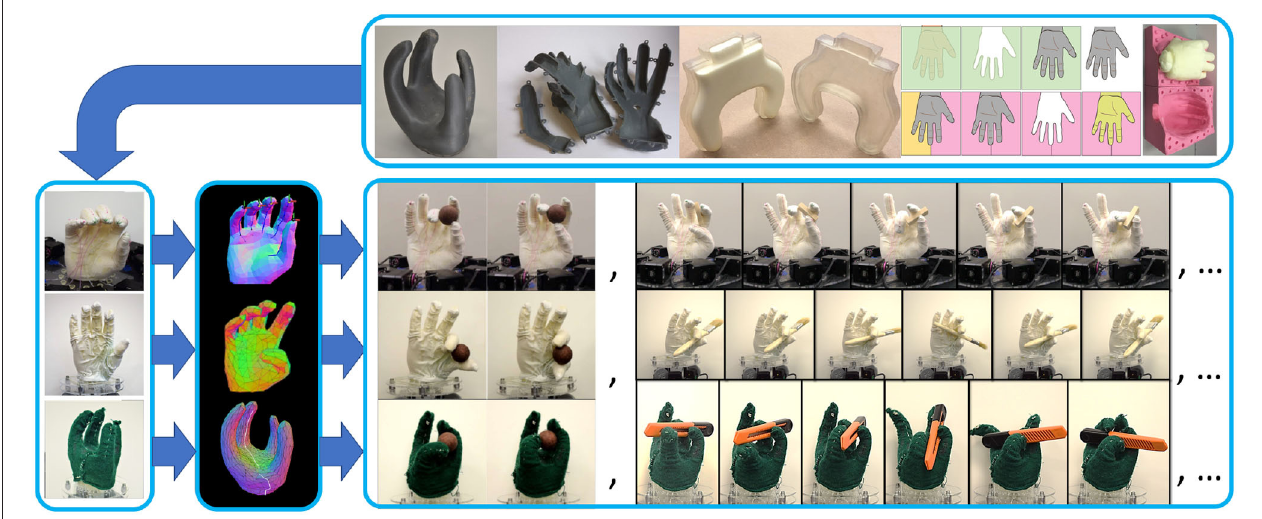
FIGURE 1 | From the top in the direction of the arrows we show: (1) Highly diverse, highly complex hand morphologies can be rapidly and in-expensively fabricated using simple 3D-printing and casting methods. (2) The hands are driven using embedded tendons integrated with the foam via textile skins. (3) Customized, interactive soft-body simulators allow for exploration of designs, actuator configurations, and planning strategies. (4) A variety of complex and dexterous manipulations can be performed across a wide range of hand designs, demonstrating the capabilities, and tremendous potential of soft foam